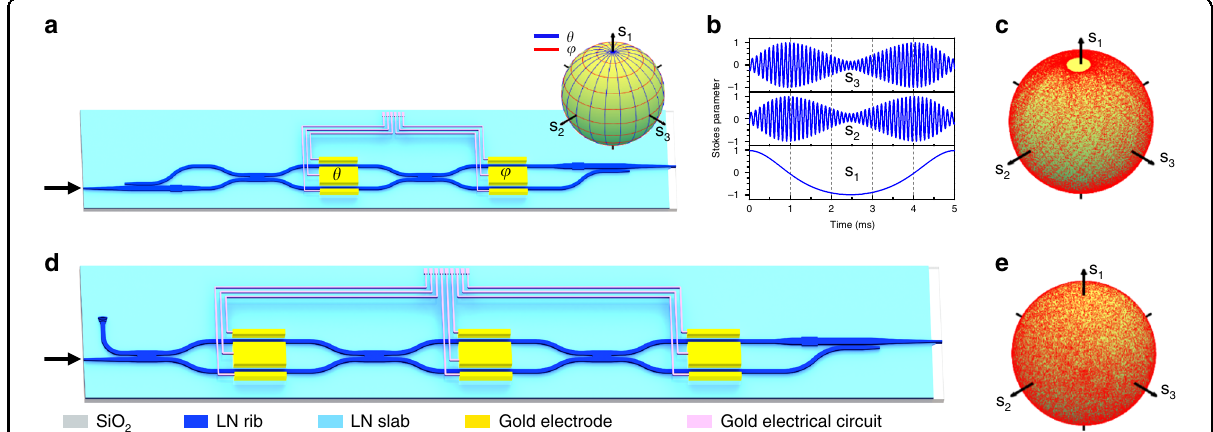
Fig. 2 Performance of the device for arbitrary SOP generation. a The schematics of the device for the arbitrary SOP generation. Inset: the position of SOP on the Poincaré sphere when changing θ (blue line) or φ (red line) of the electro-optic (EO) phase shifters. b The measured Stokes vectors as a function of time when applying two triangle wave signals with frequencies of 200 Hz and 10 kHz to θ and φ EO phase shifter, respectively. c The measured Stokes vectors on the Poincaré sphere of the output from the device, indicating a polarization extinction ratio (PER) of 22.8 dB. d The schematics of a multi-stage device with an improved PER. e The measured Stokes vectors of the output from the multi-stage device, indicating a PER of 41.9 dB